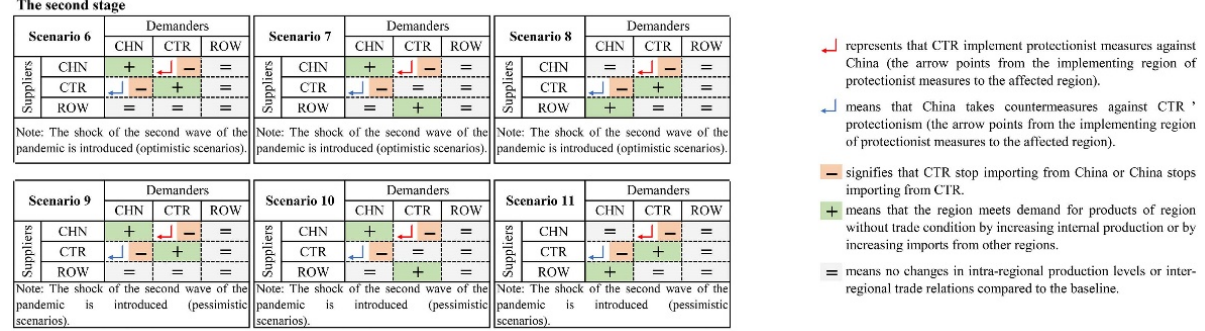
Figure 1. Design of baseline scenarios and scenarios for COVID-19.